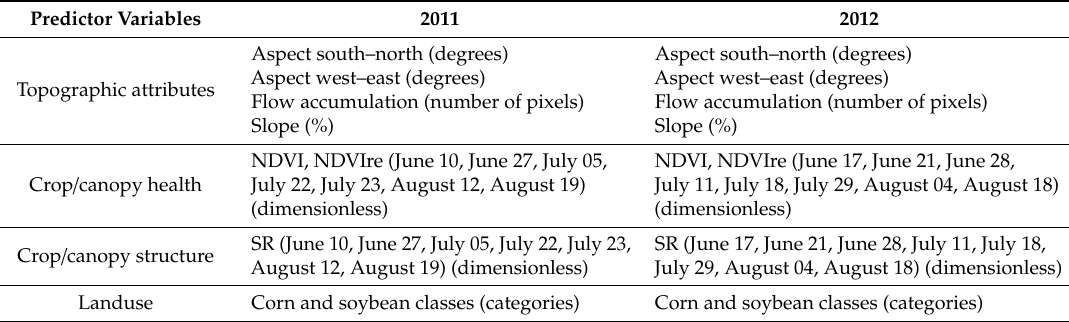
Table 4. Predictor variables used in the ANN analysis for years 2011 and